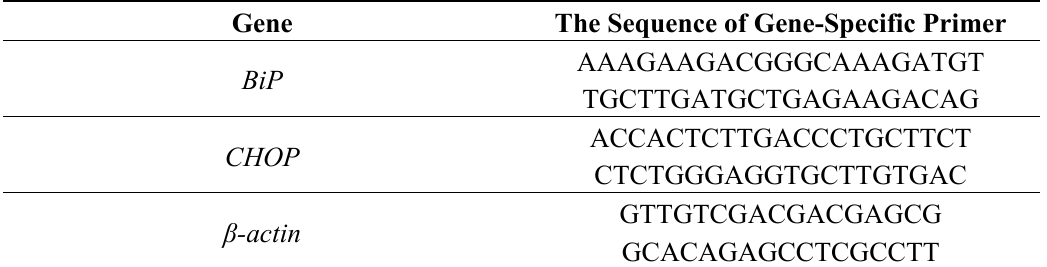
Table 1. The sequence of gene-specific